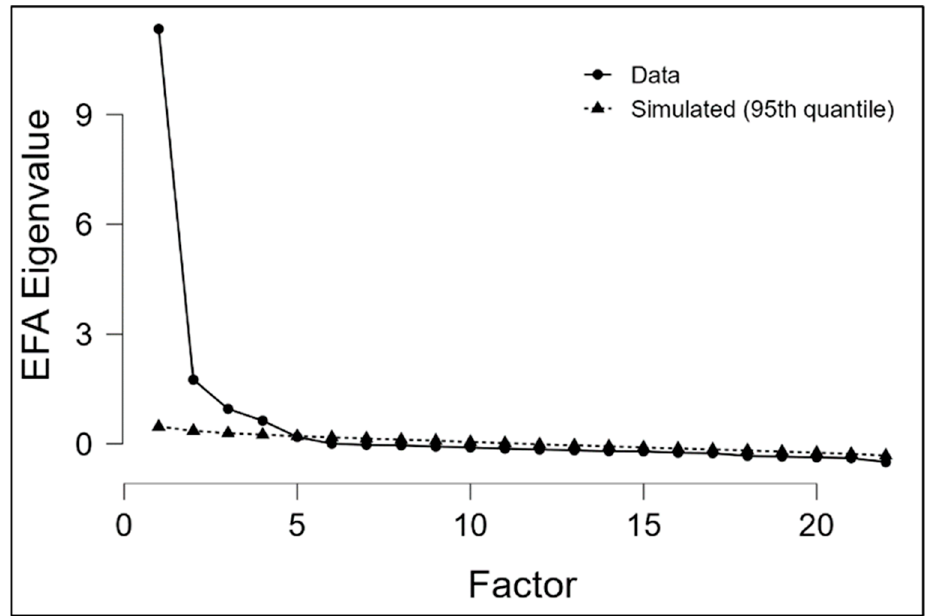
Figure 1. Parallel analysis with scree plot suggesting four-factor structure (First study). Table 1. Exploratory factor analysis: factor loadings of four-dimensional structure and reliability measures using Cronbach’s alpha and McDonald’s omega. First study.